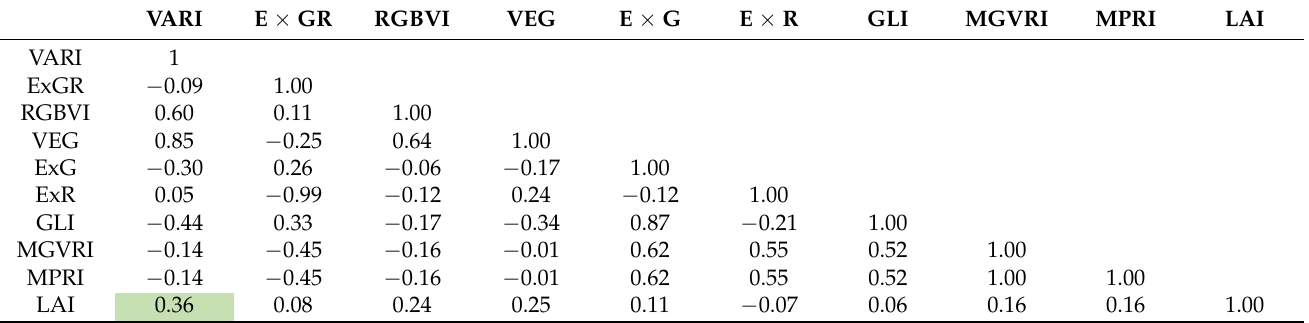
Table 2. Correlation between VIs and LAI in the second phase of the phenological cycle of the coffee.